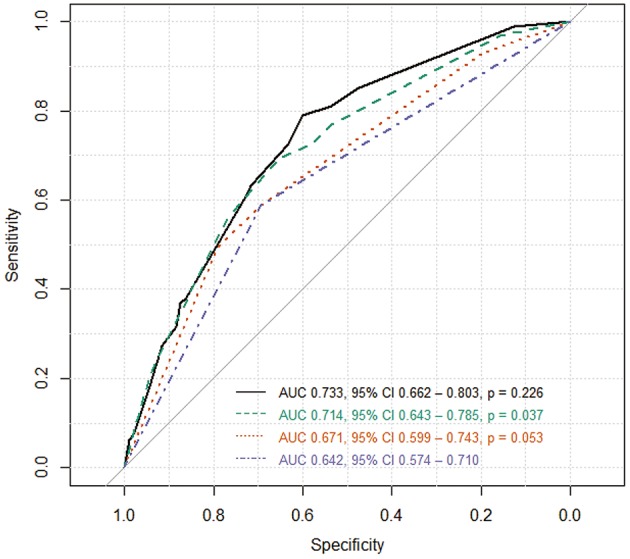
Receiver operating characteristic (ROC) curve. The accuracy of differentiating SCAS from ACAS was measured using several combination of factors associated SCAS: ROC curve of DWMH alone (blue line), DWMH and absent plaque calcification (orange line), DWMH, absent plaque calcification, and GRE HV sign (green line), and DWMH, absent plaque calcification, GRE HV sign, and increased cerebral blood volume (black line). The combination of all four factors (black line) yielded the best accuracy. AUC indicates area under the ROC curve; CI, confidence interval; p, p-value comparing the two AUCs.